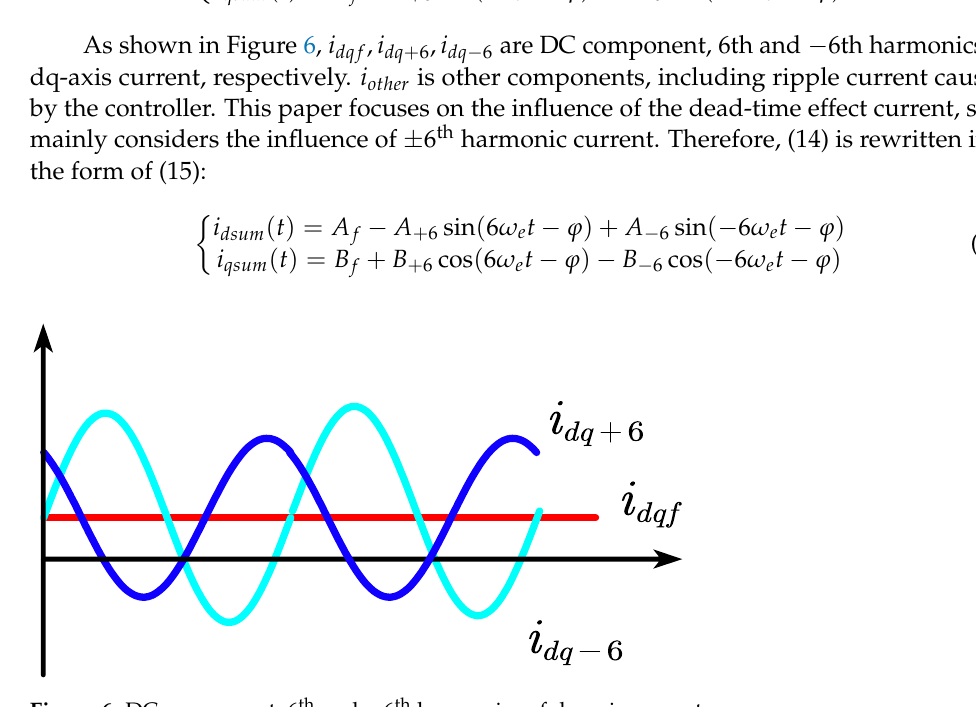
Figure 6. DC component, 6 th and − 6 th harmonics of dq-axis current.